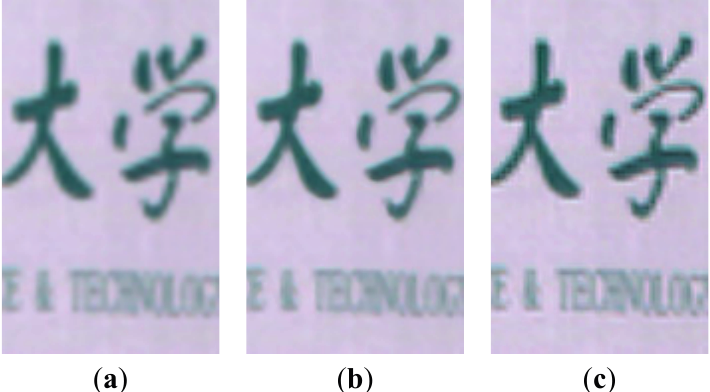
Figure 8. The cropped portions of the Figure 5b–d (color composite of R: 31, G: 20, B: 8). ( a ) bicubic interpolation method; ( b ) SR-SR method; ( c ) the proposed method.